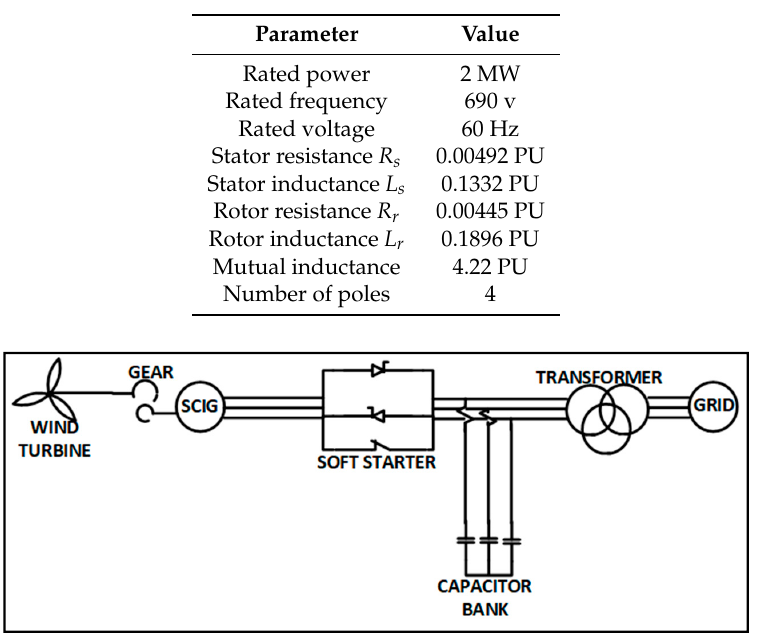
Figure 1. Schematic diagram of the squirrel cage induction generator (SCIG).